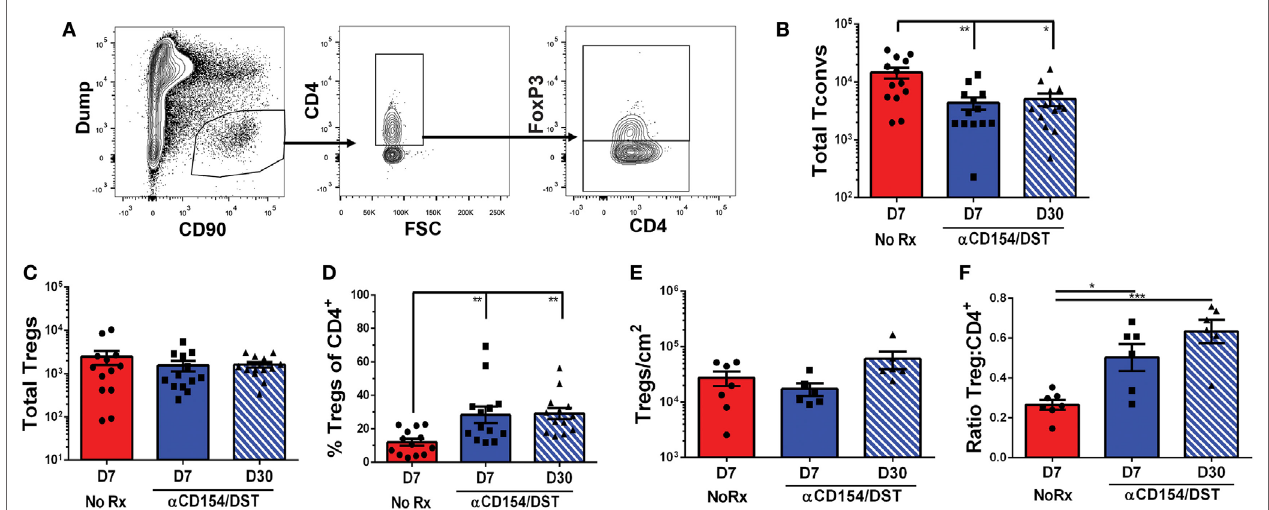
FigUre 4 | Regulatory T cells (Tregs) infiltrate comparably into allografts in rejection and tolerance while conventional T cell (Tconv) infiltration is reduced in tolerance. C57BL/6 recipients were as described in Figure 1 . On day 7 or day 30 post-transplantation, mice were sacrificed and their grafts and graft-infiltrating cells were analyzed by flow cytometry (a–D) or immunohistochemistry (e–F) . (a) Gating strategy for graft-infiltrating CD4 + Tregs. (B) Total number of graft-infiltrating FoxP3 – CD4 + Tconv and (c) FoxP3 + CD4 + Tregs. (D) Percentage of FoxP3 + cells among CD4 + graft-infiltrating T cells. (e) Total number of FoxP3 + cells per cm 2 from entire heart histology sections and (F) Ratio of FoxP3 + :CD4 + cells from matched subsections of sequentially cut histology sections (four subsections at 10 × magnification per mouse). * p < 0.01, ** p < 0.01, *** p < 0.001 by one-way ANOVA. Mean ± SEM is shown, and each point represents one mouse from 7–8 replicate experiments ( n =